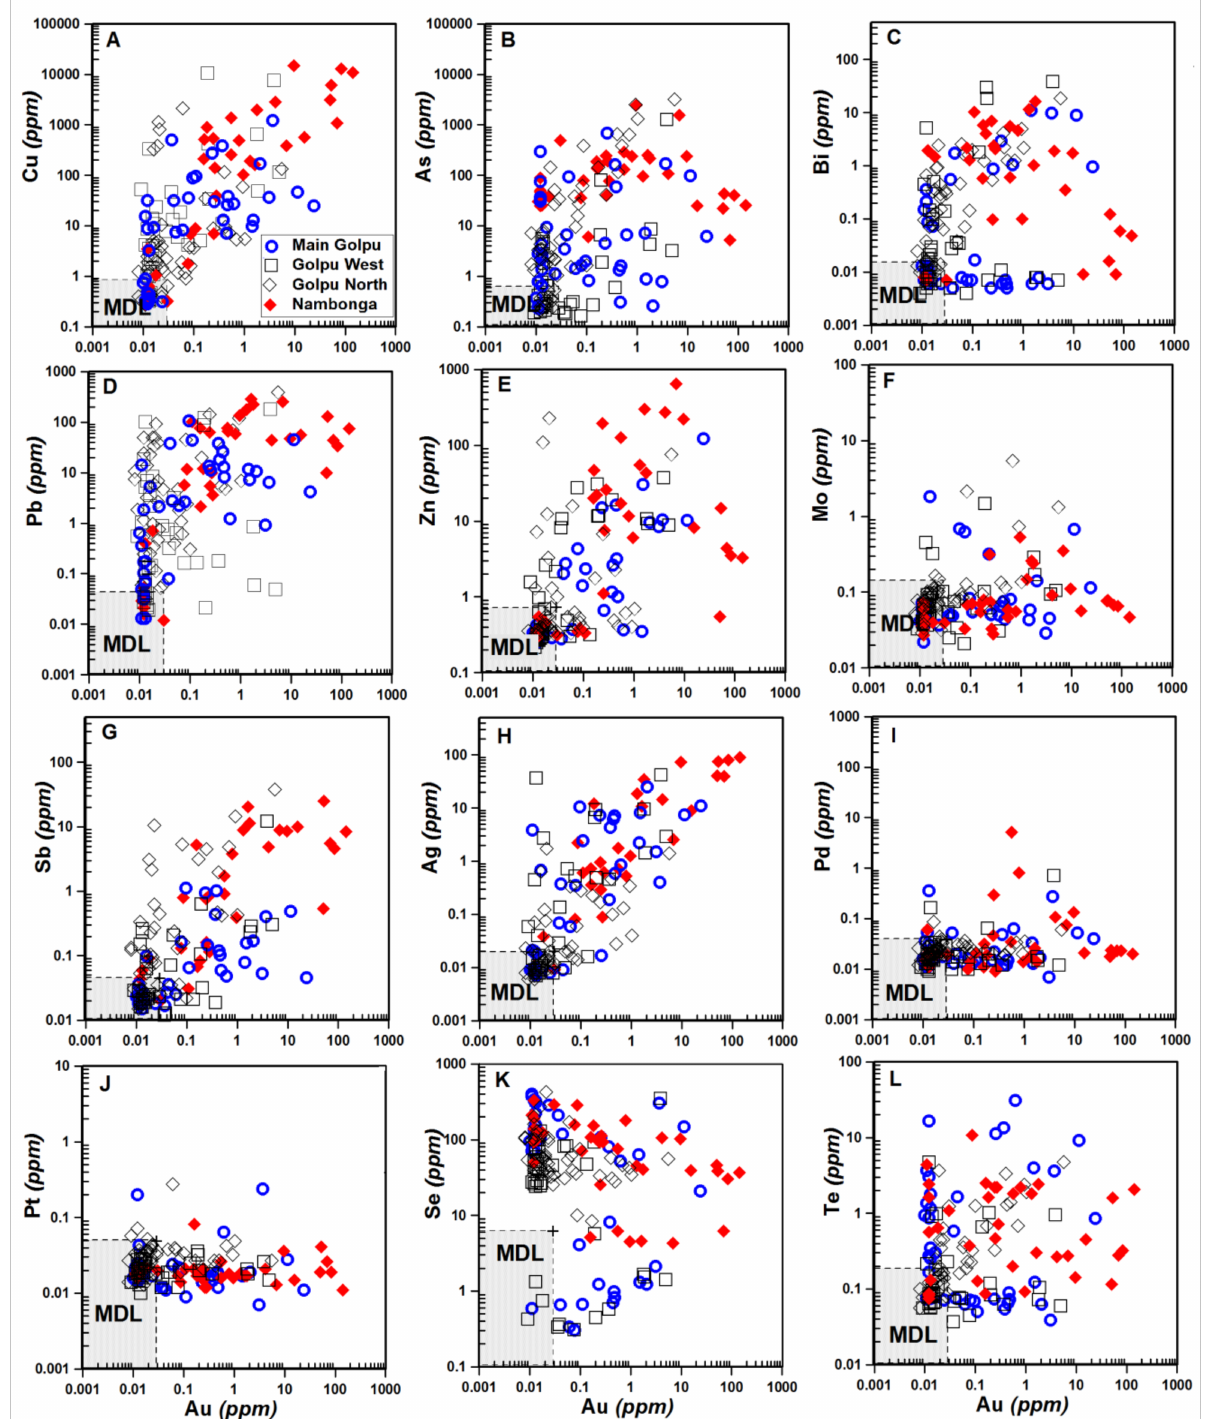
Figure 5. Log-plots of the trace element concentrations in the pyrite samples from the Nambonga North and Golpu porphyries, ( A ) Au versus Cu, ( B ) Au versus As, ( C ) Au versus Bi, ( D ) Au versus Pb, ( E ) Au versus Zn, ( F ) Au versus Mo, ( G ) Au versus Sb, ( H ) Au versus Ag, ( I ) Au versus Pd, ( J ) Au versus Pt; ( K ) Au versus Se, and ( L ) Au versus Te. MDL is abbreviated for Minimum Detection Limit. The full results are shown in Appendix